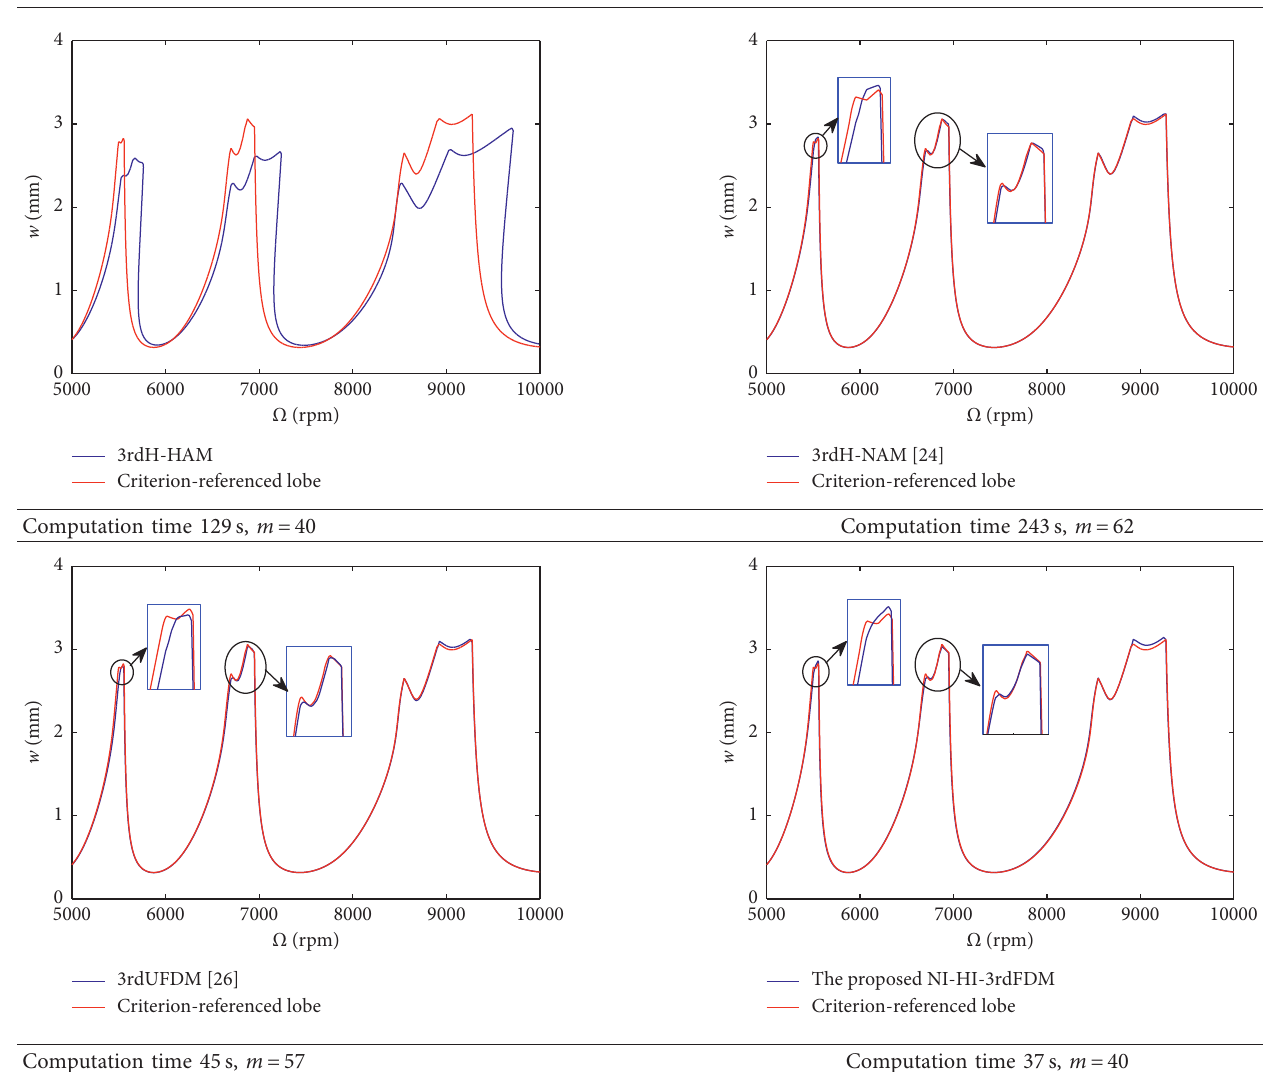
Table 5: Comparison of SLDs between the proposed NI-HI-3rdFDM and existing